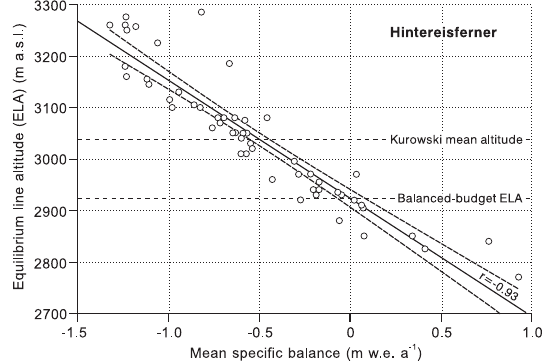
Figure 3. Equilibrium line altitude (ELA) plotted against mean spe- cific mass balance of Hintereisferner, Austrian Alps. Dashed lines denote 95% confidence interval around the regression line accord- ing to Student’s t -statistic.